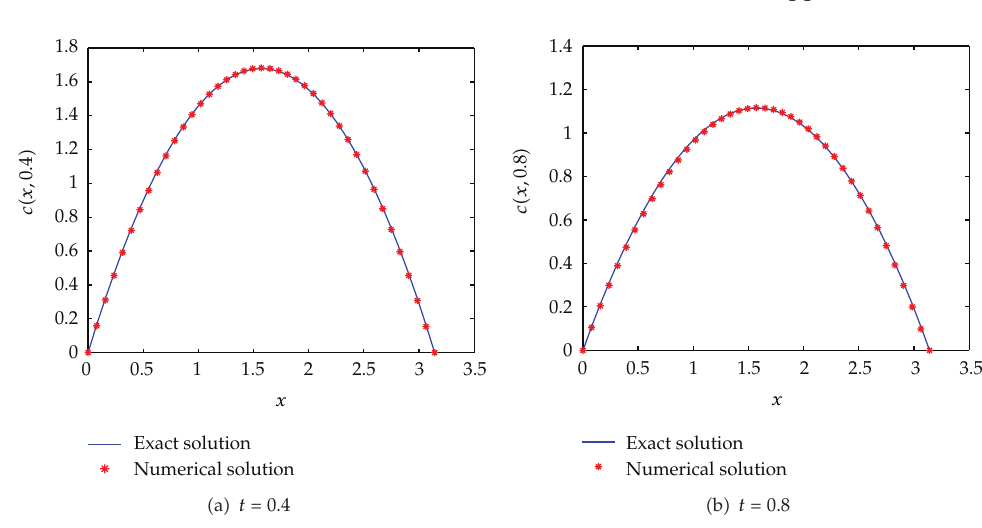
Figure 1: The exact and numerical solutions with M (cid:8) N (cid:8)